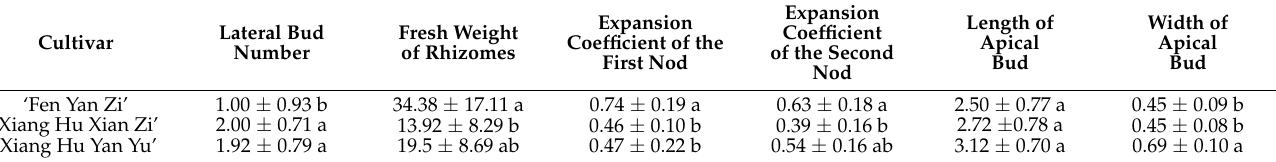
Table 4. Comparison of rhizomes harvested from three cultivars in the last growth period.